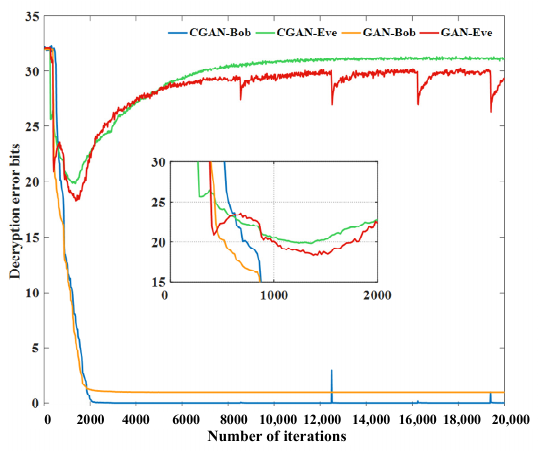
Figure 13. Comparison of training results in 64-bit scenarios.